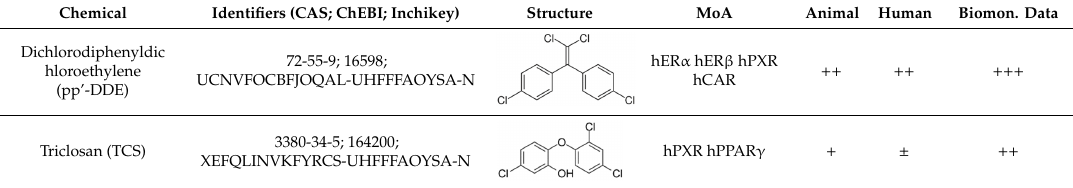
Table 1. Classes of MDCs and the initial set of model compounds that will be tested in GOLIATH, putative human nuclear receptor (NR)-mediated mechanism of action (MoA) and weight of evidence from animal and human studies as well as the availability of data on human exposure from biomonitoring studies. Chemical Identifiers (CAS; ChEBI; Inchikey)